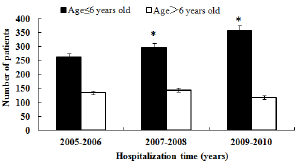
Figure 2. Numbers of hospitalized patients in the age subgroups (age # 6 years old vs. . 6 years old) in different years (P , 0.05).